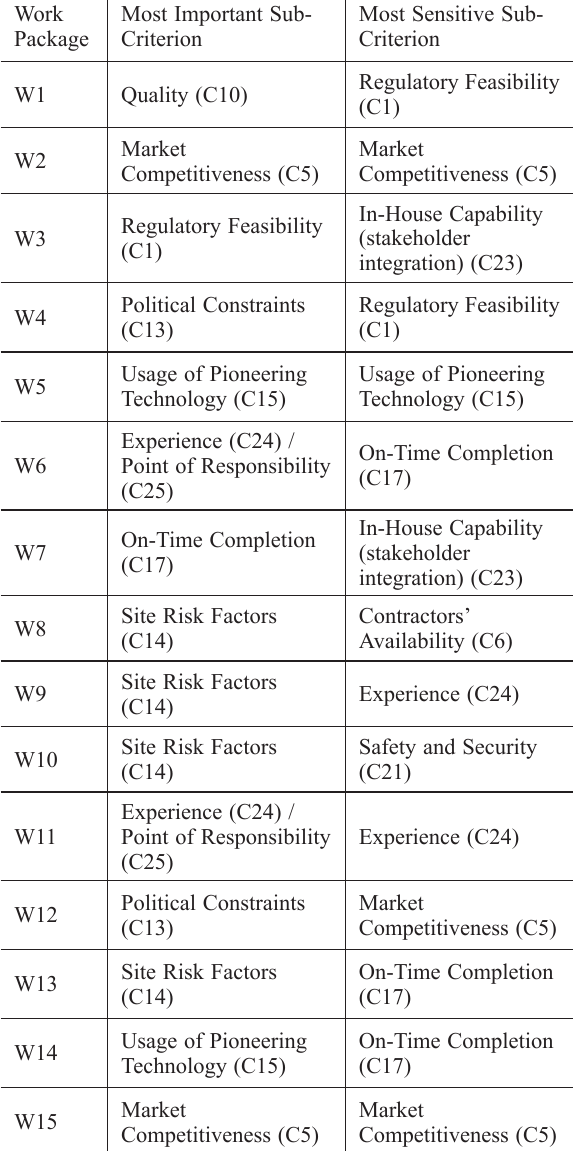
Table 6. Most sensitive alternative procurement/delivery system(s) with respect to all 15 work packages Work